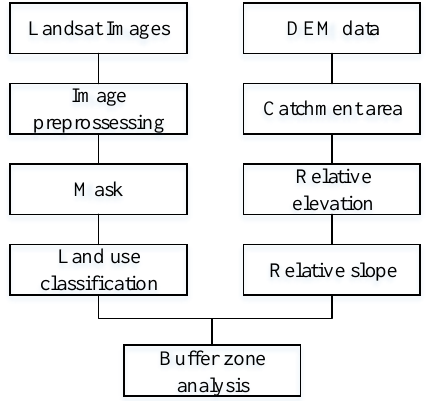
Figure 2. Buffer zone analysis process